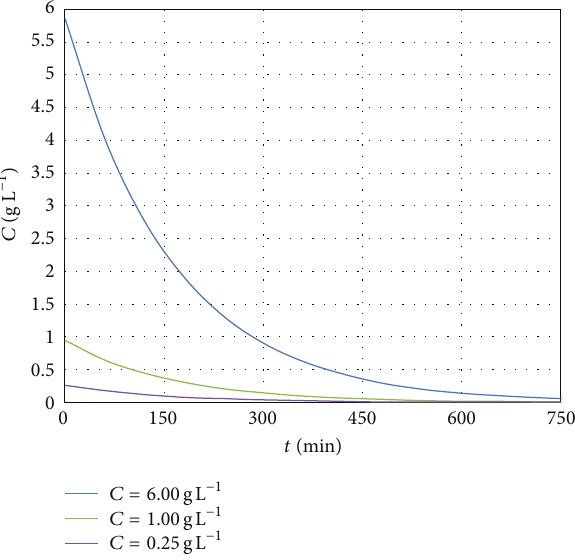
Figure 4: Input salt concentration measured at the top of the column during the experiment.